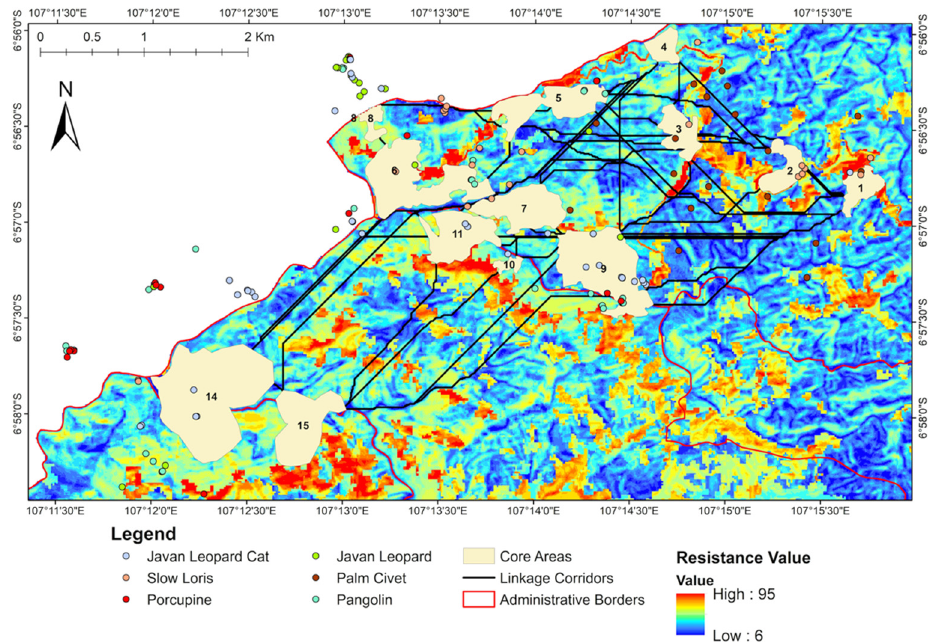
Figure 4. Map of resistance values and ecological network among core areas.